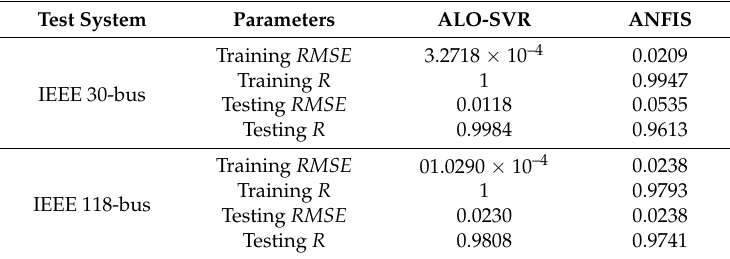
Table 6. Statistical coefficient of actual and predicted values.